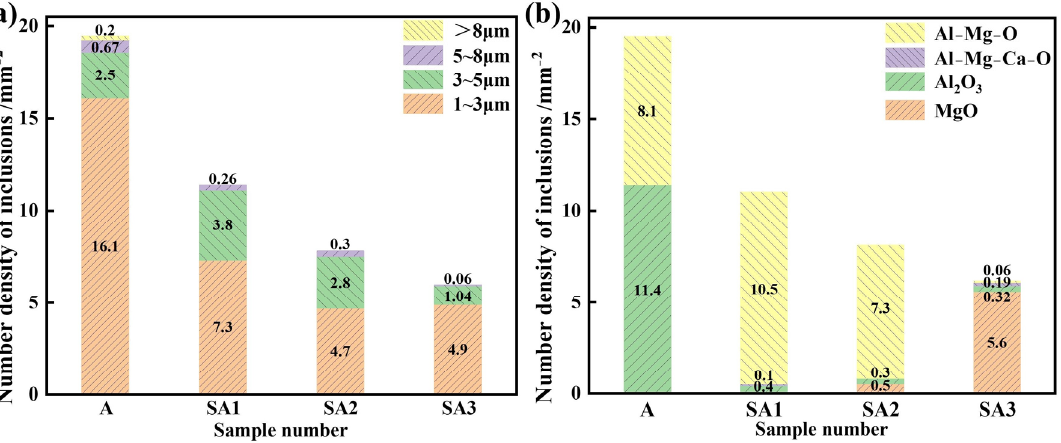
Figure 7. Di ff erences between S1 and S3 in the inclusion number density of the molten steel samples: ( a ) di ff erent inclusion sizes and ( b ) inclusion types.